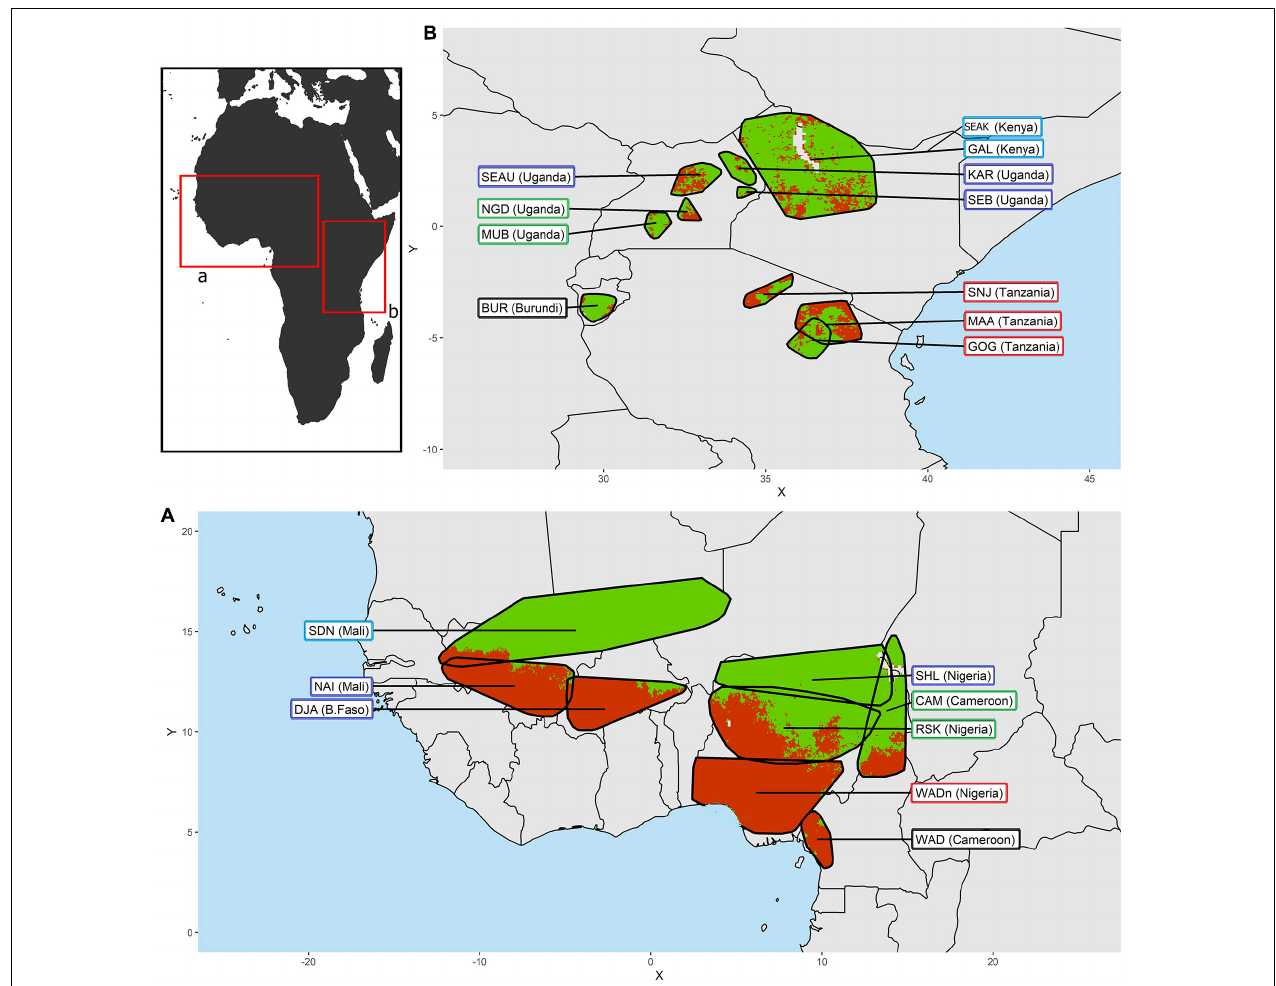
FIGURE 1 | Distribution areas for (A) the West-Central African goat breeds and (B) the East African goat breeds. In each area, the green color reflects an absence of tsetse flies while the red color identifies their presence according to Wint and Rodgers (2000). The frame of the breed name labels is colored according to the climatic clustering (see details in Figure 2